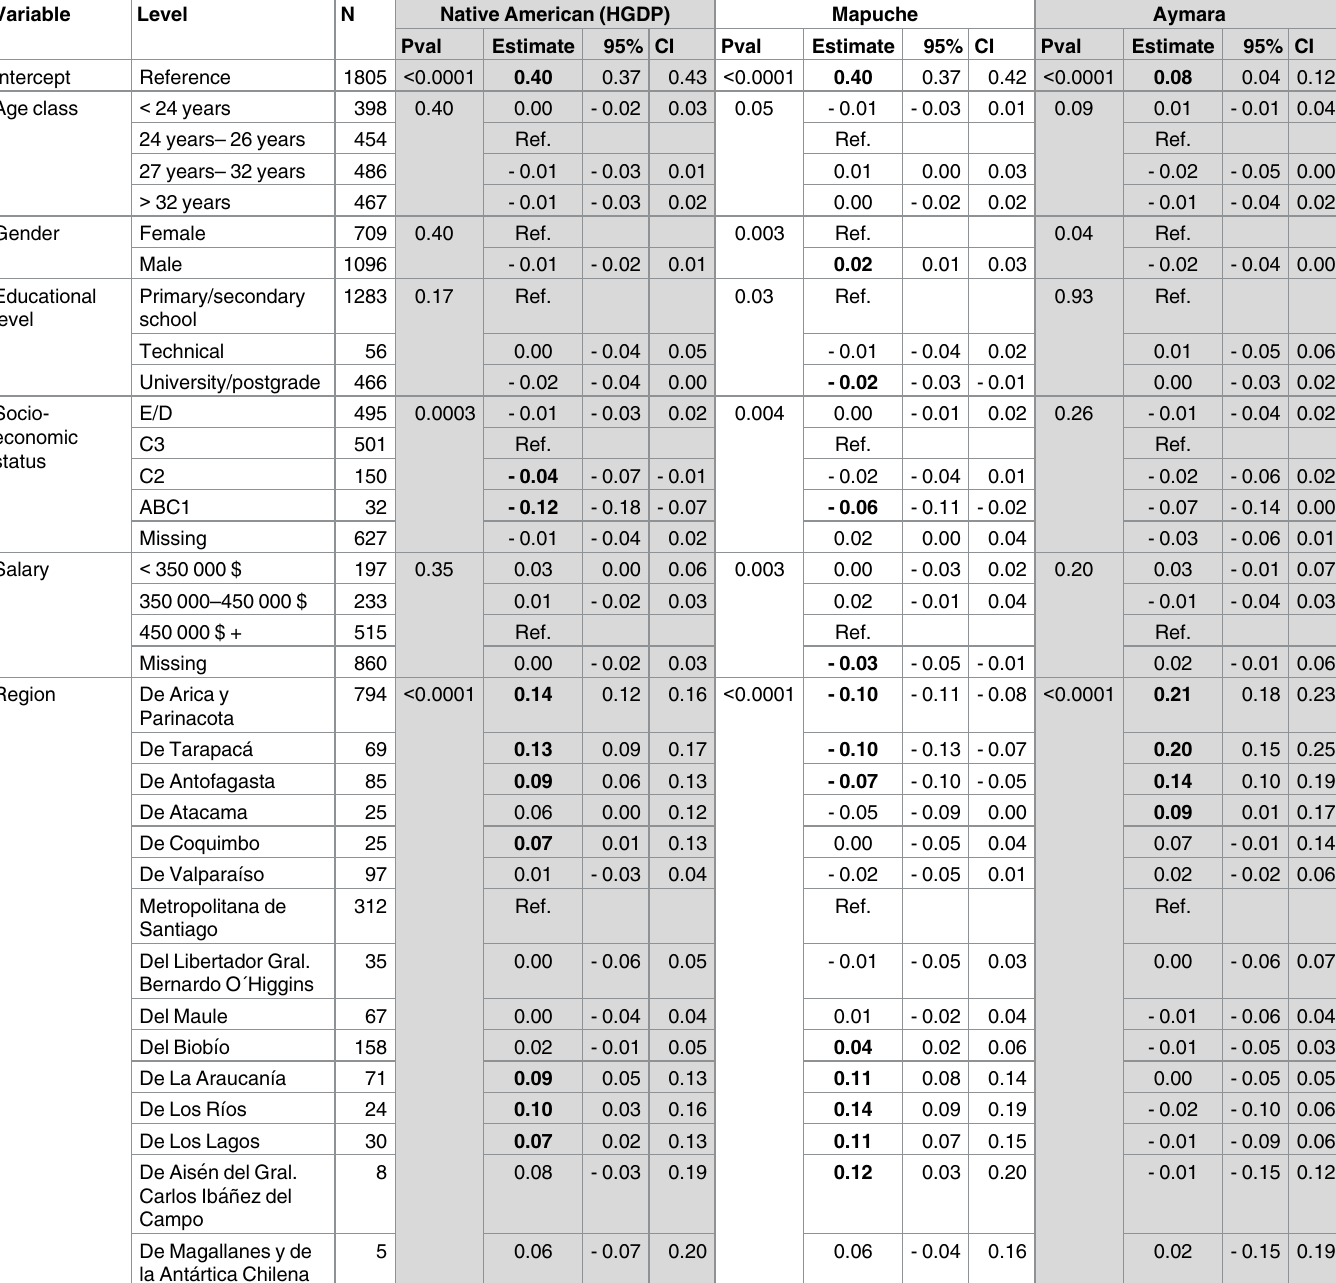
Table 1. Estimated averageNative American,Mapuche and Aymara proportions, and differences in the ancestrycomponents by age class, gen- der, educational level, socioeconomic status, salary and region.